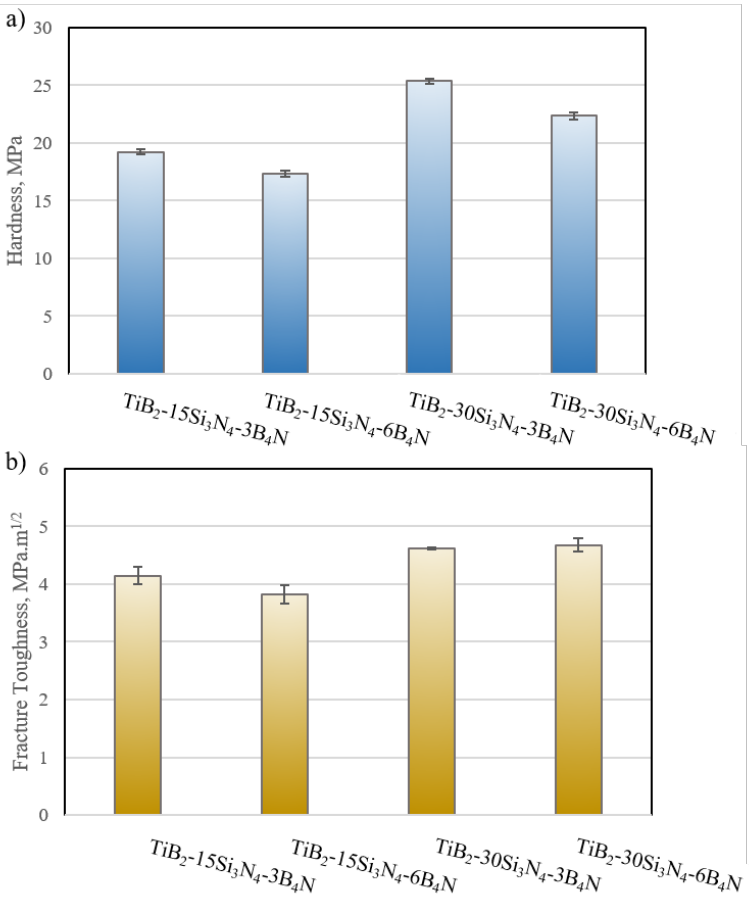
Figure 11. Mechanical properties of sintered composites: ( a ) hardness and ( b ) fracture